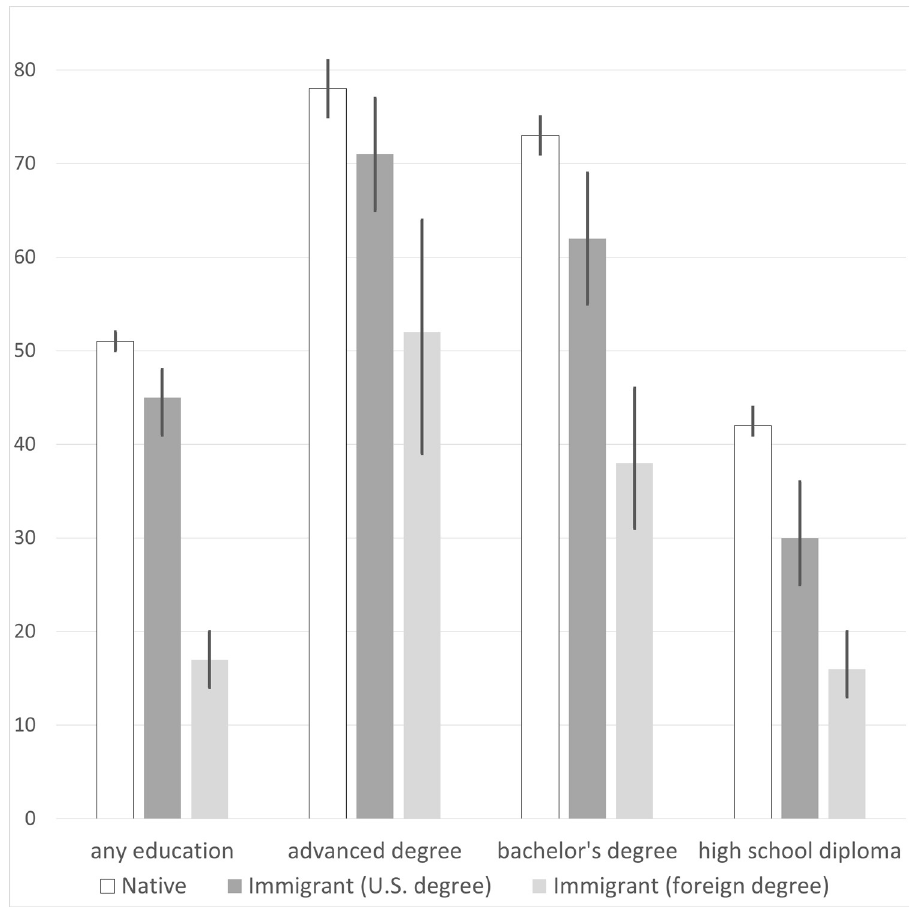
Fig 1. Average percentile scores on PIAAC literacy, by immigrant-education group. The vertical line at the top of each bar indicates the 95% confidence interval. The scores are not age-adjusted.